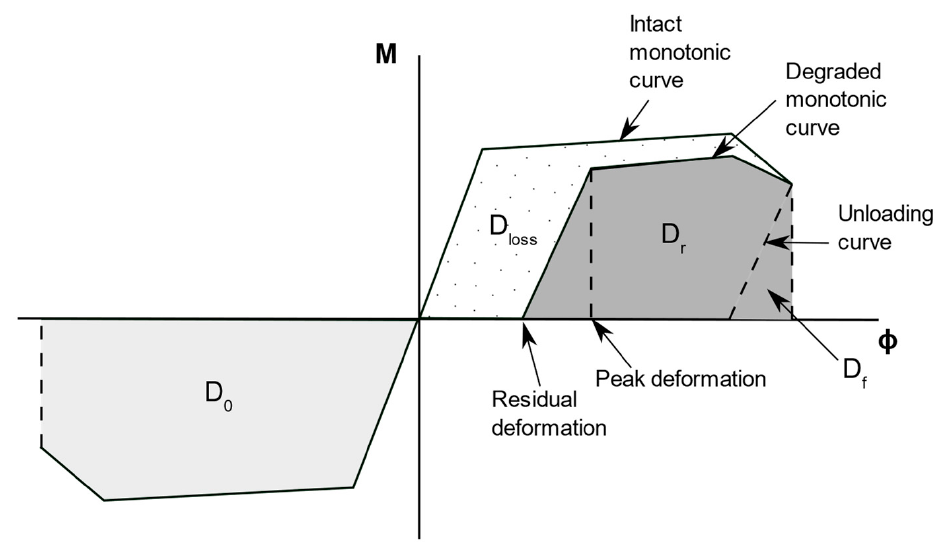
Figure 1. Schematic illustration of the MBDI [29].